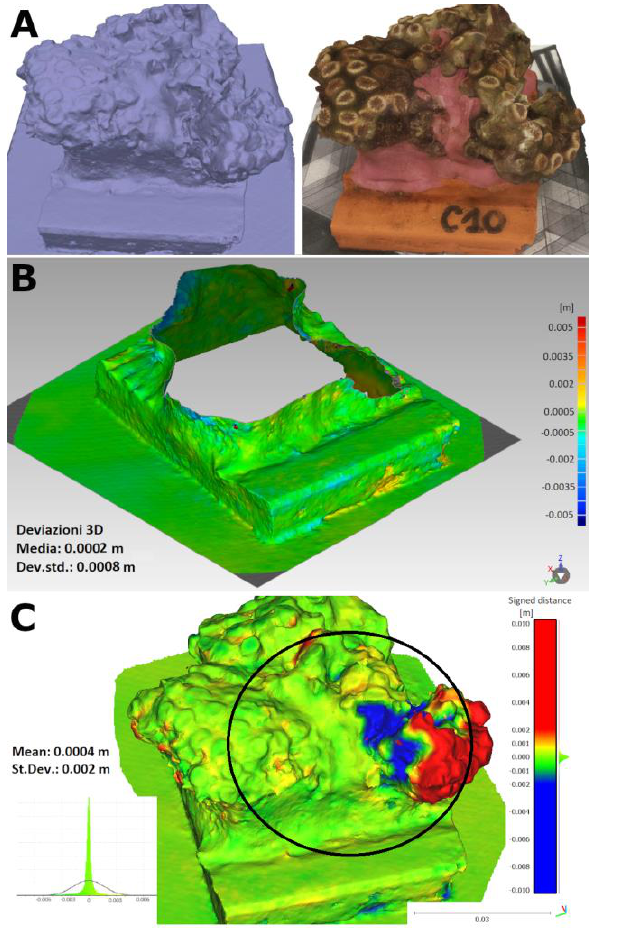
Figure 4 . A, B- fluorimetry images acquired after and before the event, white circle points out the impact area. C, D- map of fluorescence intensity values. E- representation of relevant pixel before (white) and after (red) the